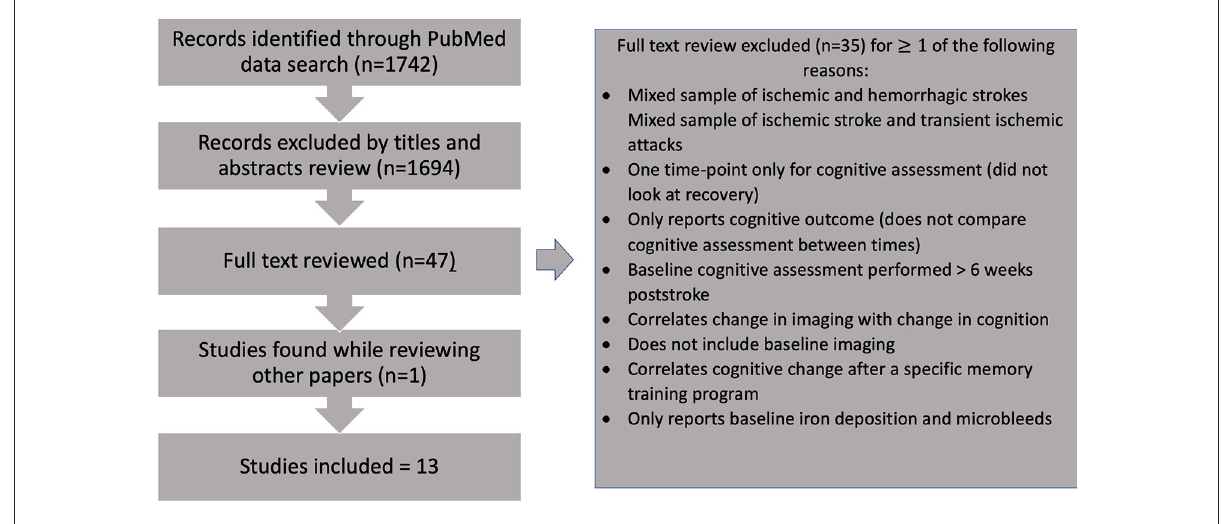
FIGURE1 Flow diagram of study selection